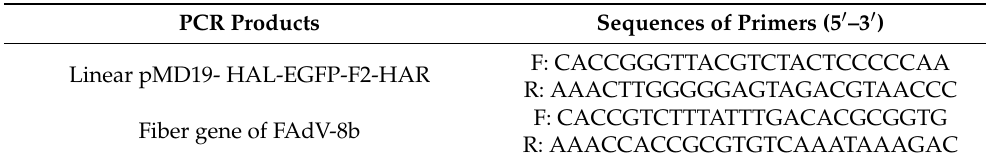
Table 2. PCR primers for constructing donor